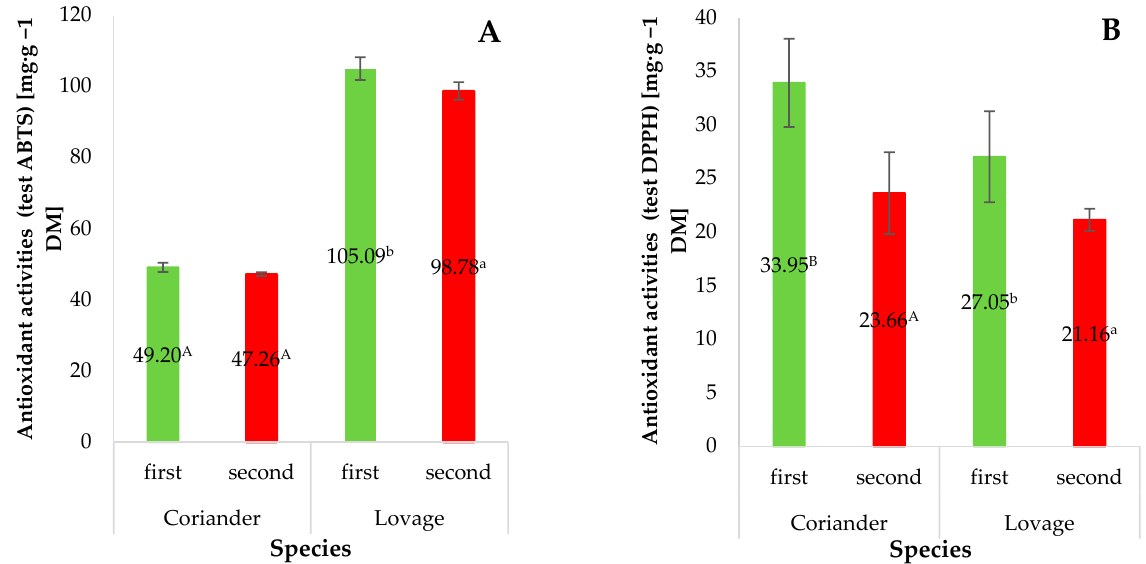
Figure 3. Antioxidant activities: ABTS test ( A ) and DPPH test ( B ) in dry leaves of Coriandrum sativum L. and Levisticum officinale relative to the fertilizer applied. Described as a Trolox equivalent. Note: ± SD; n = 3; differences between the fertilisation methods, assessed by Statistica 13.1 ANOVA test, Differences in the results between the assessment of colour in dry leaves of Coriandrum sativum L. are indicated by different capital letters, and difference between the assessment of colour in dry leaves of Levisticum officinale indicated by different lower capitals, difference at p < 0.05.